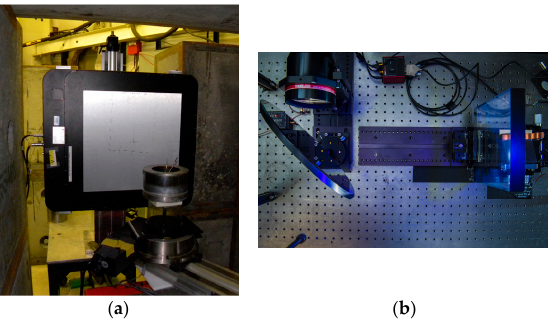
Figure 15. ( a ) A Perkin-Elmer 40 cm × 40 cm a-Si flat panel detector, model 1621, is shown located at 21 m from the Target 4 neutron production target in the inner shielding on the 4FP-60R flight path. Rotation and translation stages with an object are located in front of the flat panel; ( b ) A CCD camera (not visible) lens, mirror, plastic scintillator TOF-gated imaging setup with Cu step wedge at right.